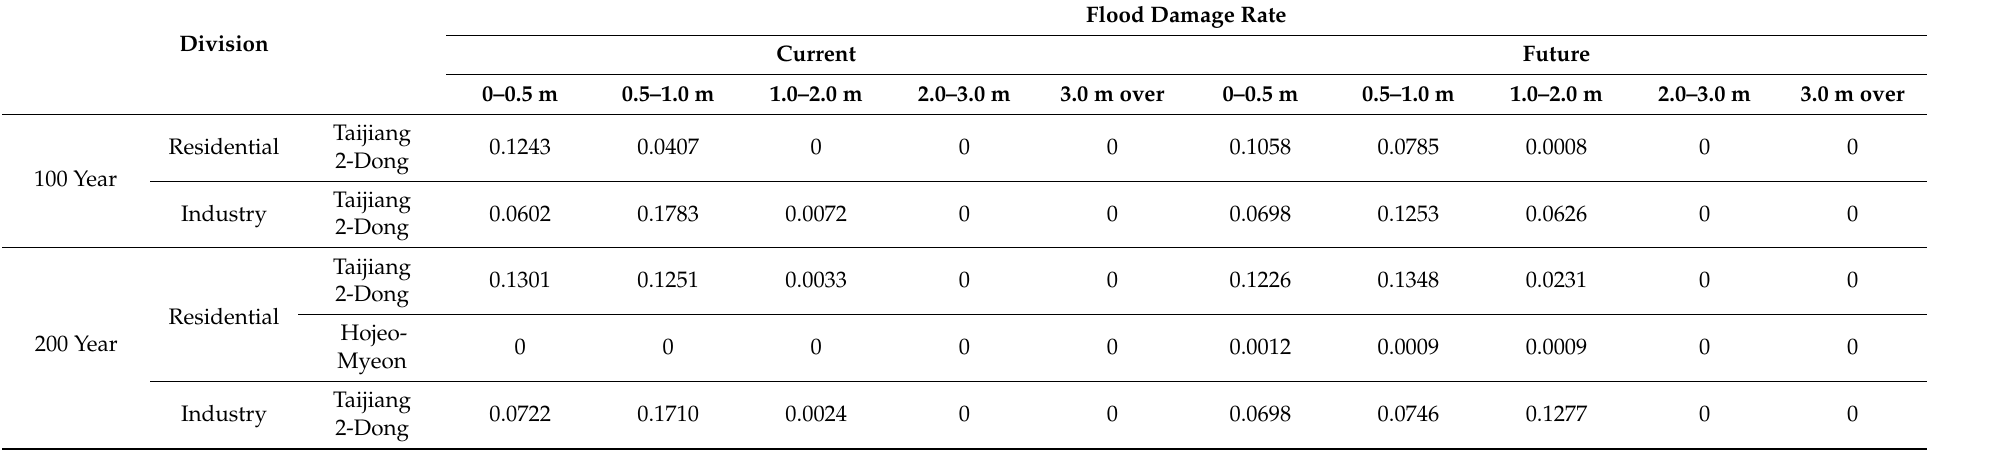
Table 3. Estimation Flood Damage Rate by Return